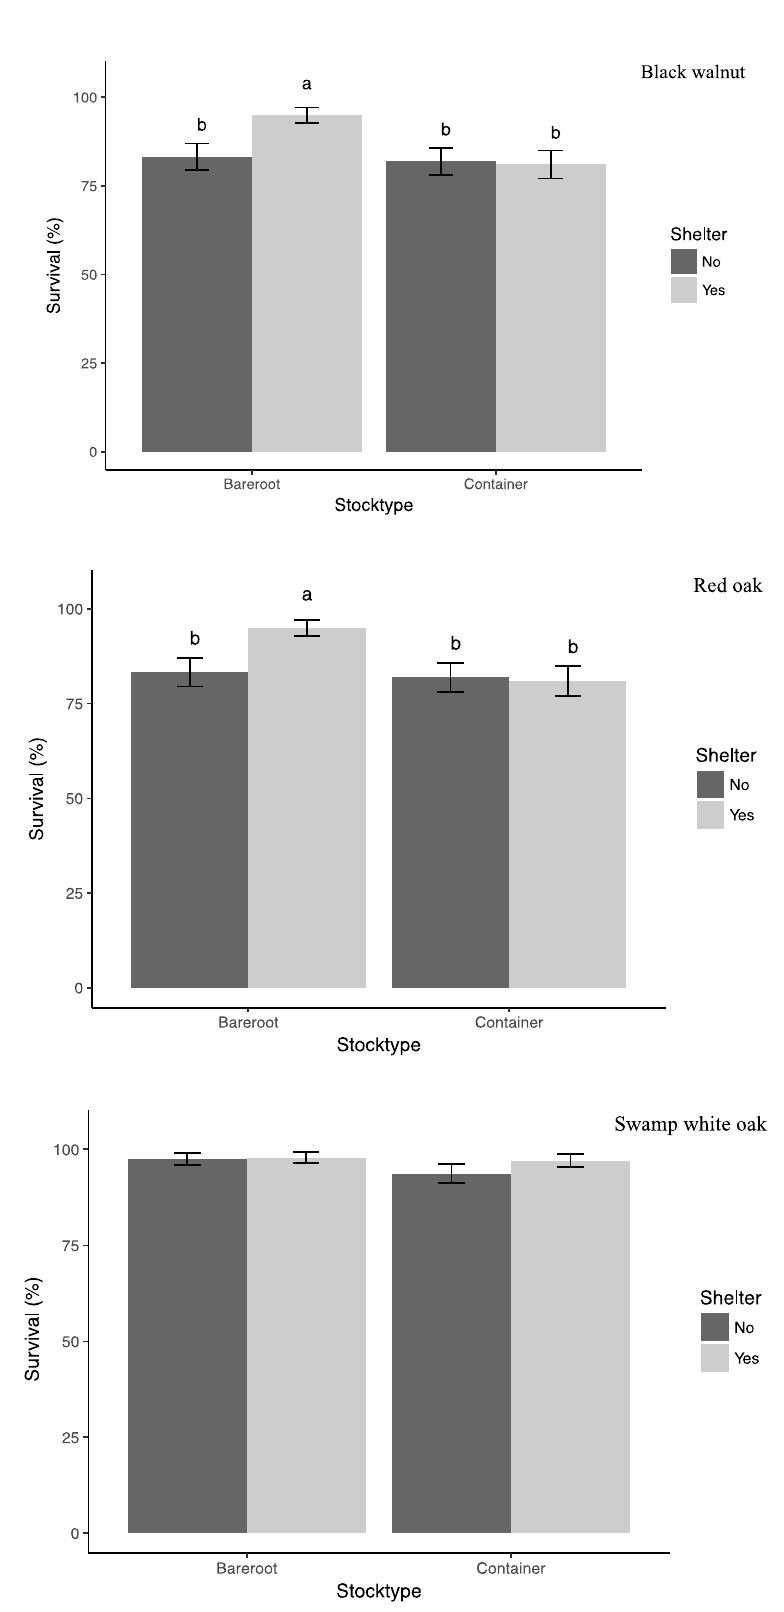
Figure 2. Percent survival after two years of black walnut, red oak, and swamp white oak for stocktype × shelter interaction. Columns represent means, and bars represent ± 1 SD. Columns with di ff erent letters are statistically di ff erent according to Tukey’s Honestly Significant Di ff erence (HSD) test at α =